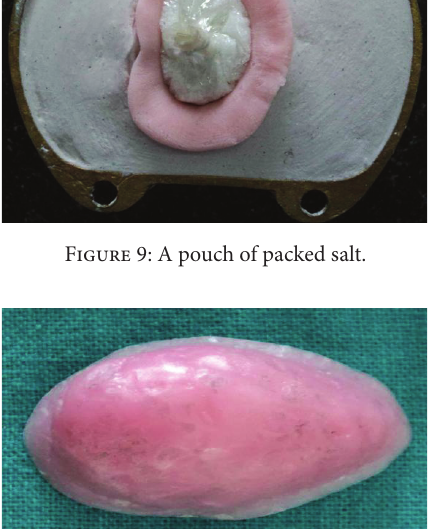
Figure 10: Defect side view of